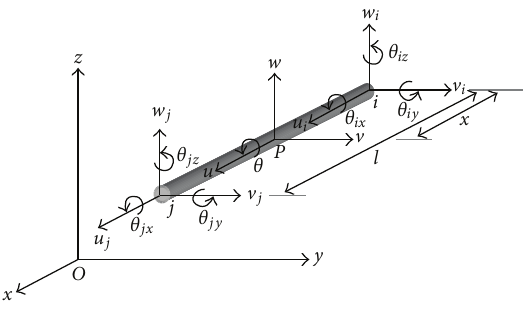
Figure 4: Nodal elastic displacement of the